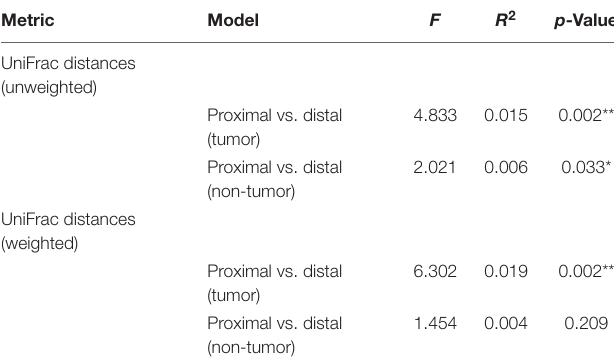
TABLE 3 | Beta diversity assessed by weighted and unweighted UniFrac